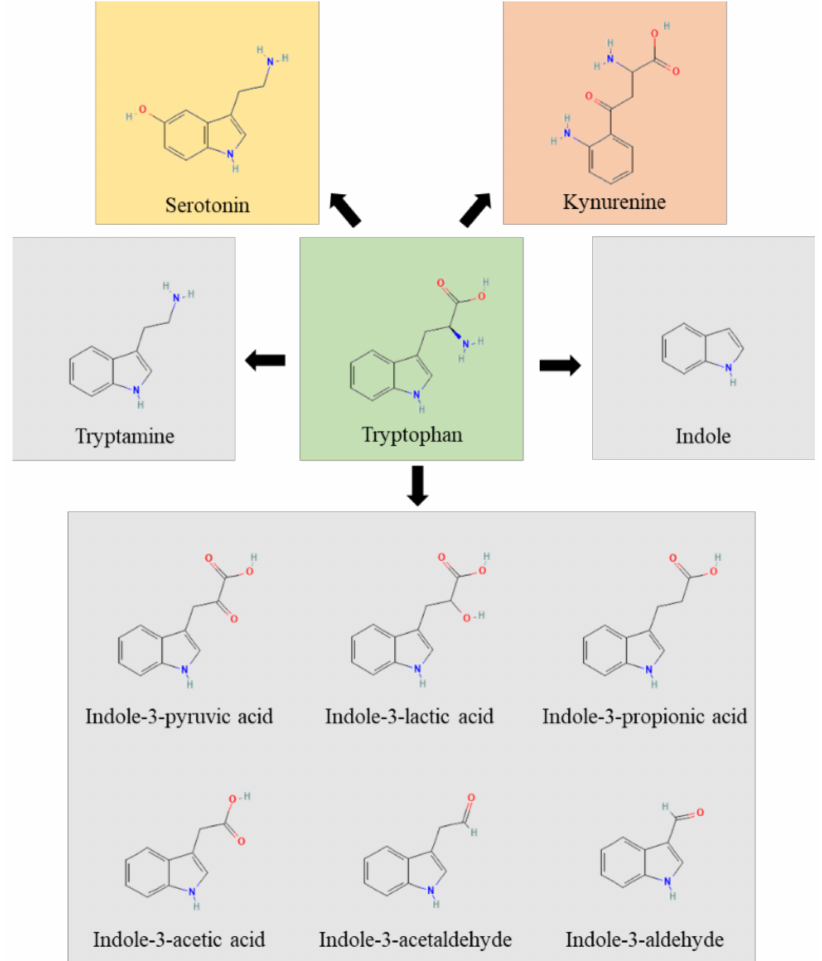
Figure 1. The figure represents the Trp (green box) metabolic pathways of host (yellow and rose boxes) and microbial (grey boxes)